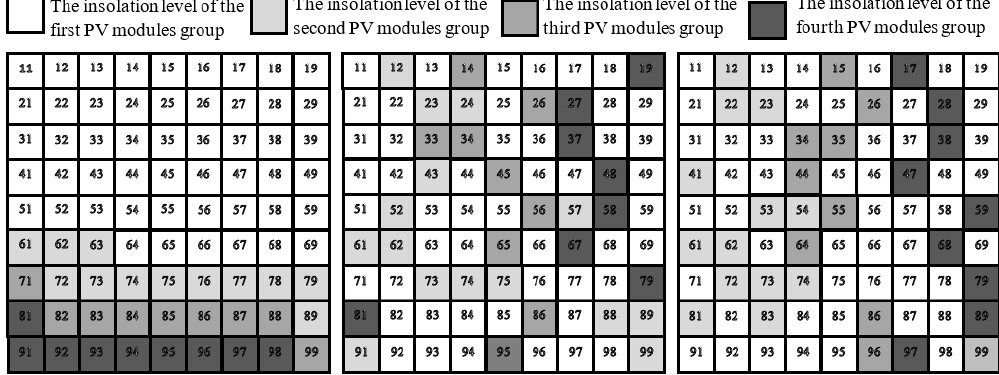
Figure 3. The configuration scheme provided by the TCT PV array, the intelligent reconfigurable PV system, and the reconfigurable TCT PV system based on GA.